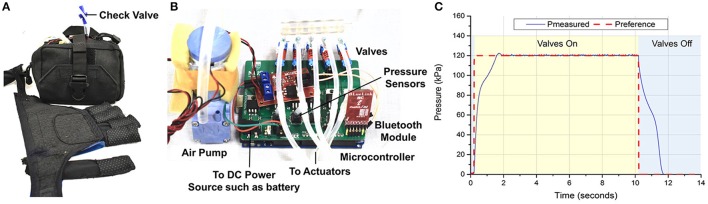
(A) Pump-valve control system integrated into a waist belt pack. (B) Inner view of the control system. (C) Step response of the controller implemented on the pump-valve control system.